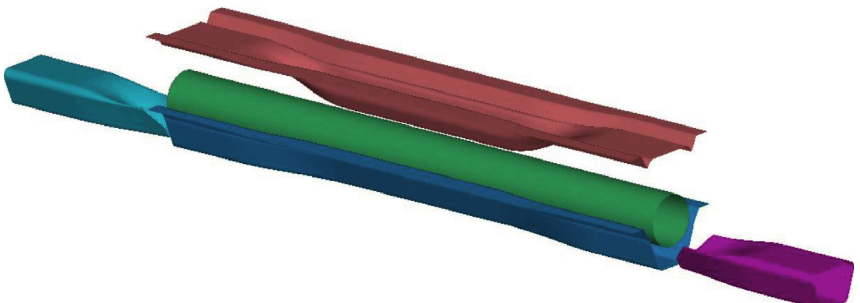
Figure 11: Preforming process scheme